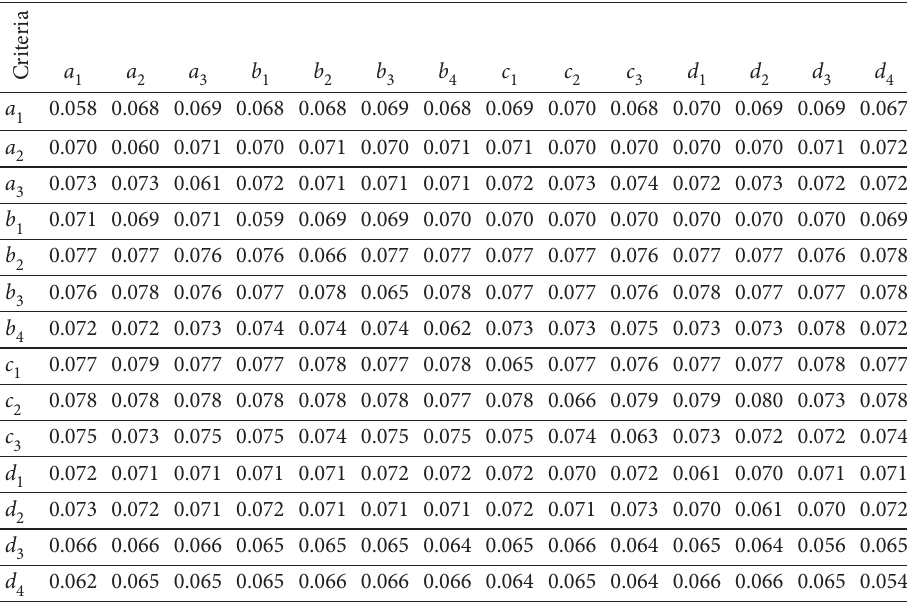
Table 7. Weighted super-matrix α W based on DANP for financial center modernization elements